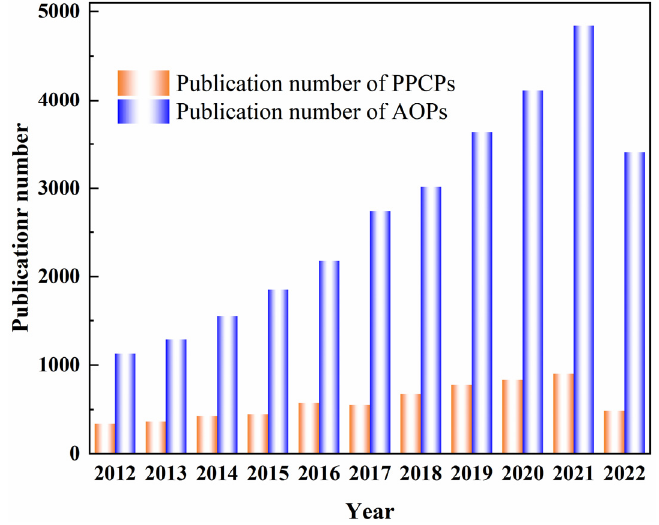
Figure 2. Number of publications on PPCPs and AOPs from 2012 to 2022 (topic keywords “pharmaceutical and personal care products” and “advanced oxidation processes” searched from web of science), data updated by 28 September 2022.